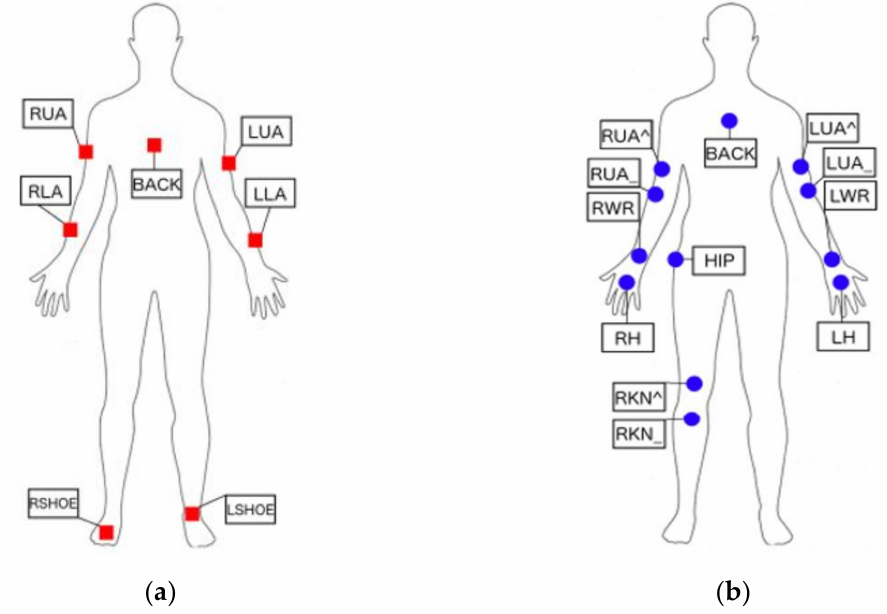
Figure 1. Placement of on-body sensors used in the OPPORTUNITY dataset: ( a ) inertia measurement unit sensor placement; ( b ) triaxial accelerometer